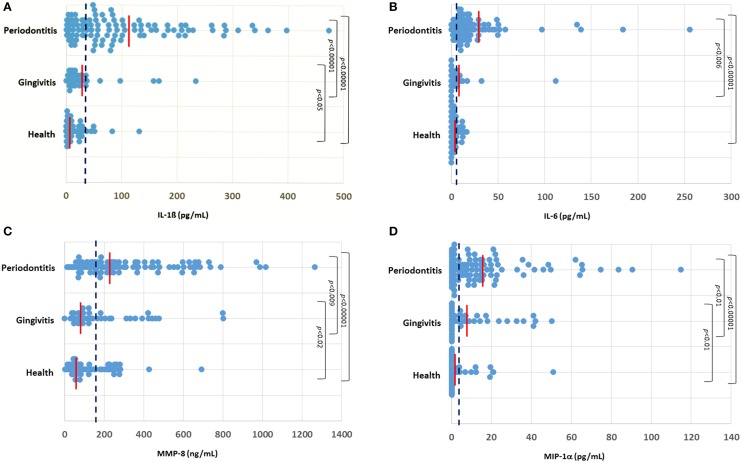
Distribution of levels of IL-1ß (A), IL-6 (B), MMP-8 (C), and MIP-1α (D) in the three groups of subjects. Each point denotes the analyte value for a patient. The vertical red line denotes the group mean and the vertical blue dashed line denotes the threshold cutoff for each analyte (IL-1ß ≥ 28 pg/mL; IL-6 ≥ 5.5 pg/mL; MMP-8 ≥ 140 ng/mL; MIP-1α ≥ 5 pg/mL).